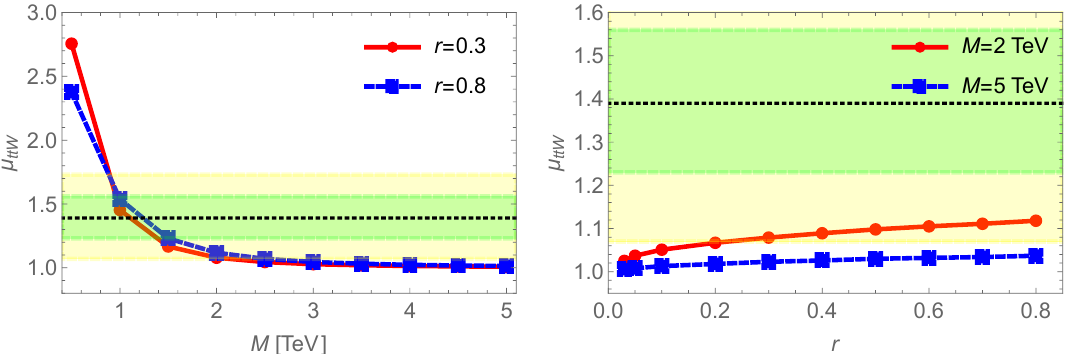
, as a Figure 8 . Ratio of the total cross-section pp → t ¯ tW with respect to the SM value, µ th t ¯ tW function of the renormalized on-shell mass M (left panel) for the fixed ratios r = 0 . 3 (red solid line) and r = 0 . 8 (blue dashed line), and as a function of the ratio r (right panel) for the fixed masses M = 2 TeV (red solid line) and M = 5 TeV (blue dashed line). The different lines correspond to the predictions based on the full propagator (pole approach), while the bands represent 1 σ (light green) and 2 σ (light yellow) deviations from the µ obs central value (black dotted line) observed t ¯ tW